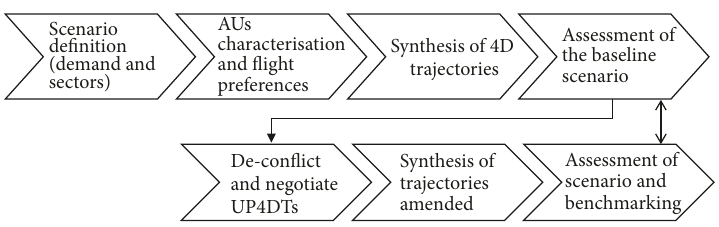
Figure 3: Methodological